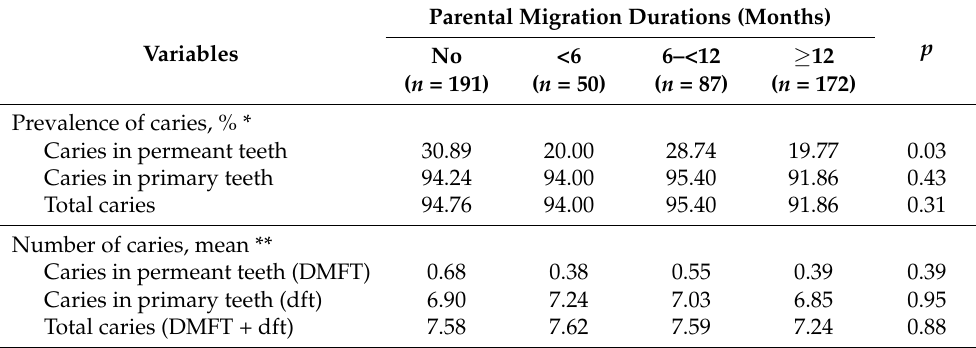
Table 3. Test linear trend in children’s dental caries among parental migration durations.